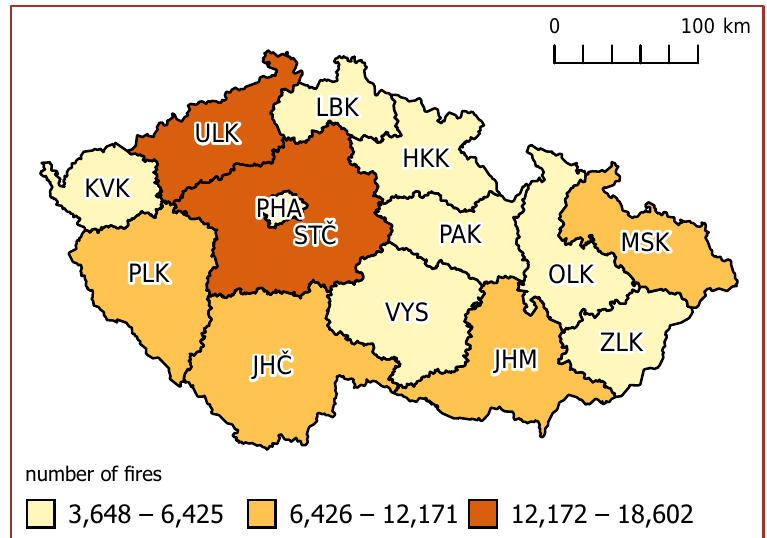
Figure 4. Spatial distribution of wildland fires in the regions of the Czech Republic. Data refer to the period 1997–2019.